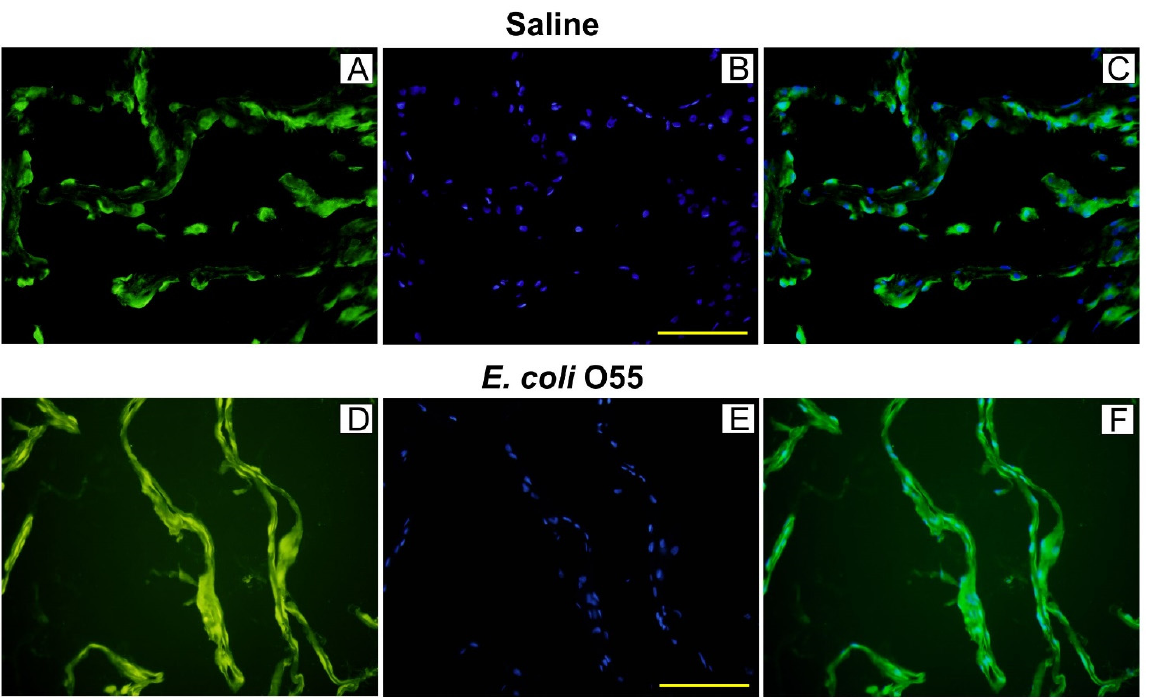
Figure 2. Colocalization of HMGB1 and cell nuclei in the amniotic membrane. HMGB1 (green; A , D ), cell nuclei (blue; B , E ), and their colocalization ( C , F ) are depicted on group representative micrographs. A bar ( B , E ) corresponds to 100 µ m.